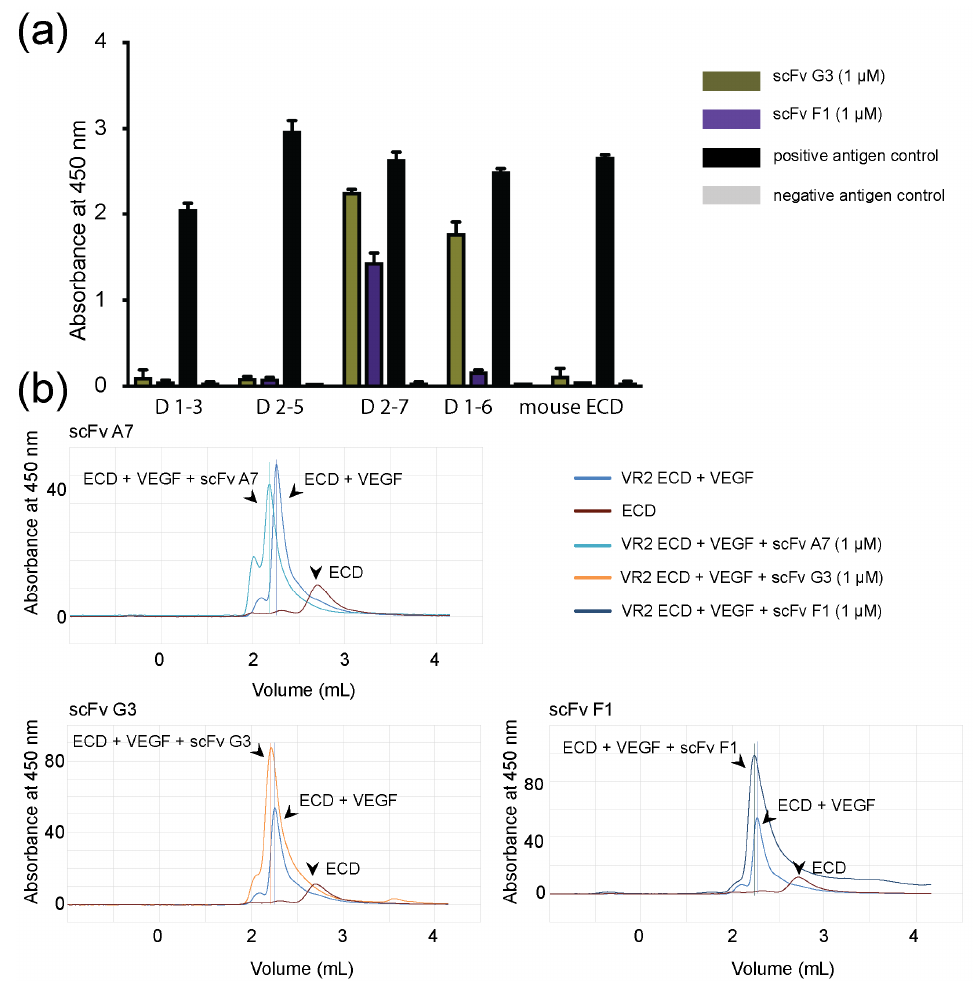
Figure 1. Analysis of scFv binding to the VEGFR-2 ECD ( a ) ELISA results show VEGFR-2 domain specificity, shown as absorbance at 450 nm. ELISA plates were coated with different length VEGFR-2 ECD constructs and exposed to 1 µ M of scFvs. Absorbance signal represents specific binding of scFvs to VEGFR-2 ECD construct. Antigen controls demonstrate wells with and without VEGFR-2 ECD construct. Presented results are the mean of three independent experiments where error bars represent ± standard deviation (SD); ( b ) Fluorescence size-exclusion chromatography results show ScFvs binding to VEGFR-2 ECD/VEGF complex. ScFvs (1 µ M) were incubated with VEGFR-2 ECD/VEGF complex, and the mixture was analyzed with FSEC. VEGFR-2 ECD/VEGF complex and VEGFR-2 ECD were used as controls. The incubation with scFvs led to the shift in the peak position to the left, demonstrating the formation of new larger species in combination with VEGFR-2 ECD/VEGF and the bound scFvs. ScFv addition did not lead to a shift in the peak position to the right, indicating that binding of scFvs did not disrupt the